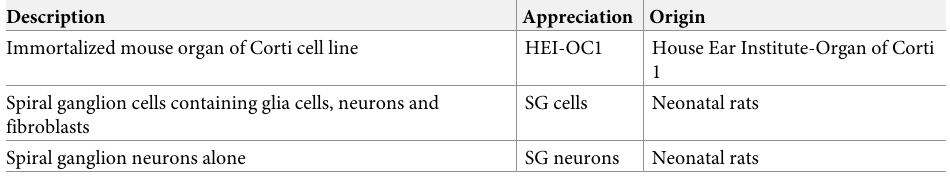
Table 1. Cell culture models of the inner ear that have been used in this